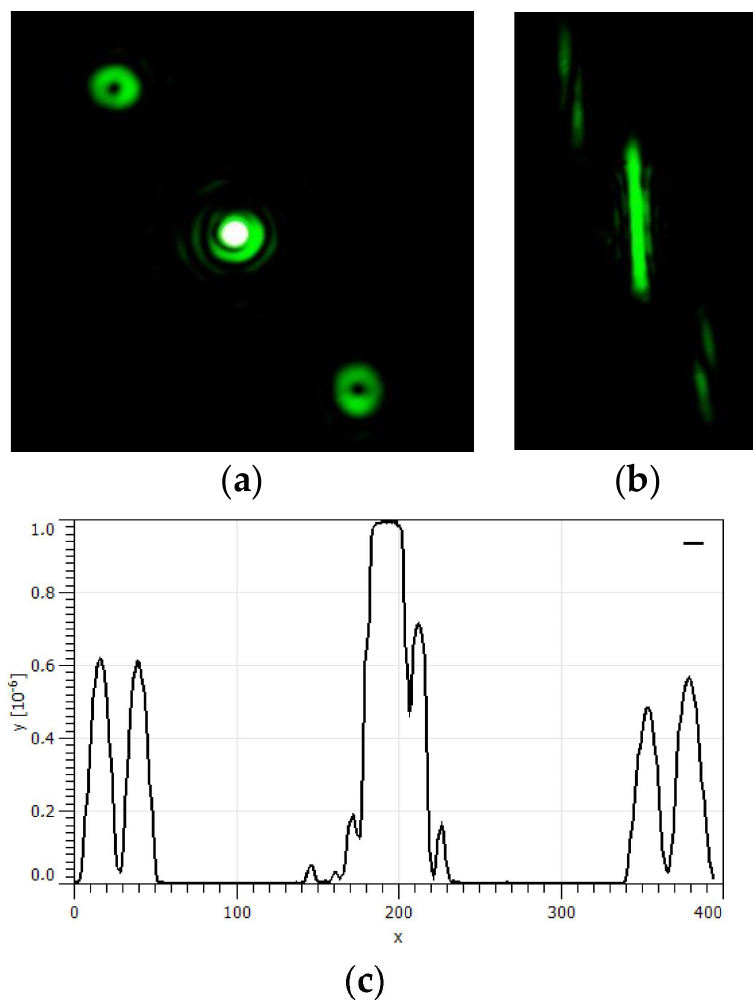
Figure 7. Intensity distributions of vortex beams: ( a , b ) before and after passing through a cylindrical